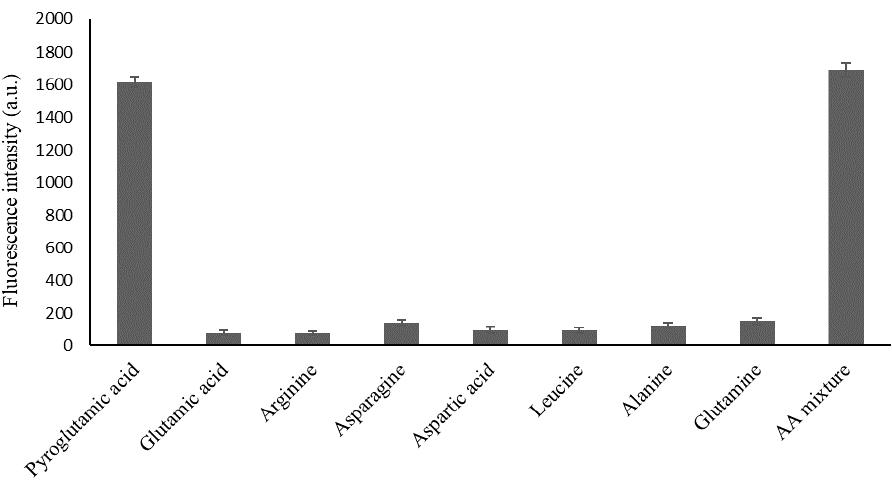
Figure 2. Fluorescence response of various amino acids with the optimized analytical protocol ( n = 3). Pyroglutamic acid: 50 µM. Amino acids: 50 µM. ( n = 3). Pyroglutamic acid: 50 µ M. Amino acids: 50 µ